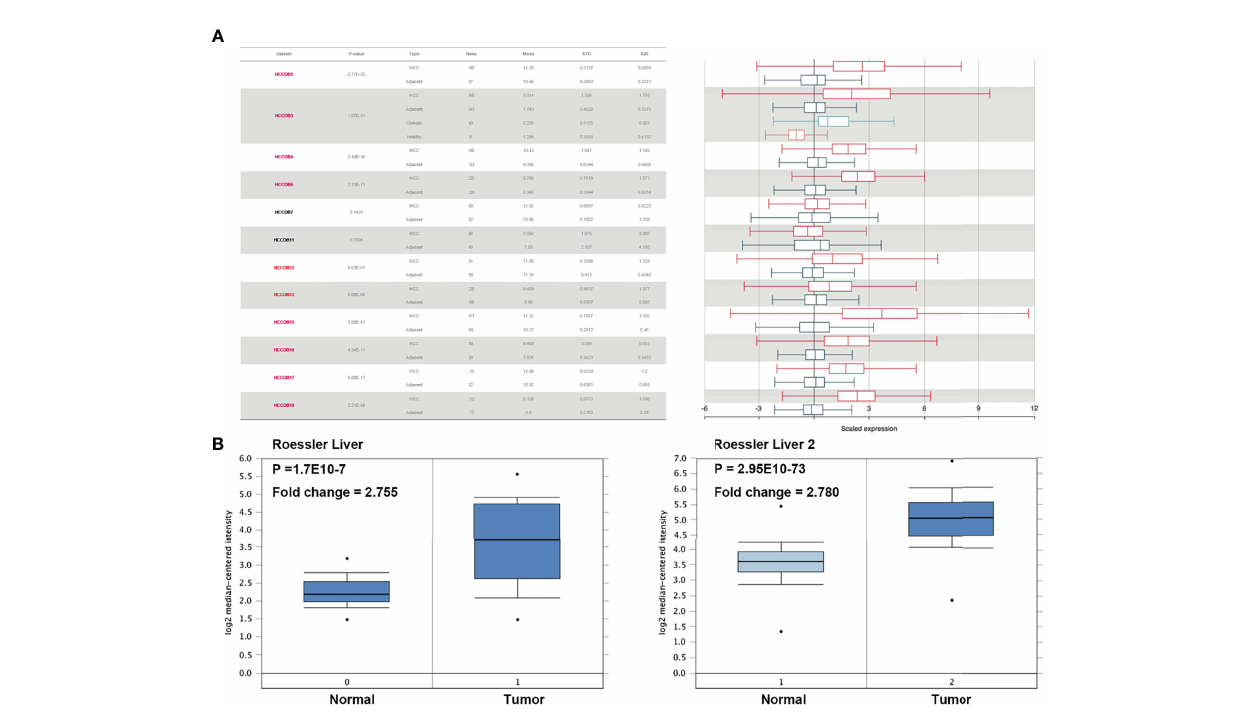
FIGURE 1 | H2AFZ transcription level in HCC. (A) Chart and plot showing the expression of H2AFZ in tumor tissues and adjacent normal tissues in HCCDB. (B) Box plot showing H2AFZ mRNA levels in the Roessler Liver and Roessler Liver 2,